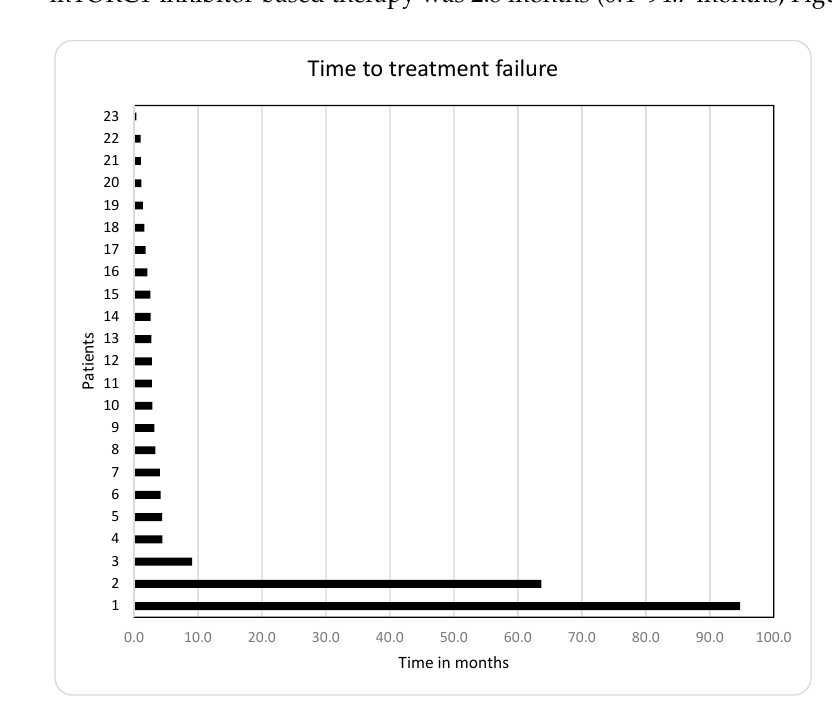
Figure 5. Time to treatment failure (TTF) in 23 cancer patients who received mTORC1-inhibitor-based therapy: the median TTF was 2.8 months.